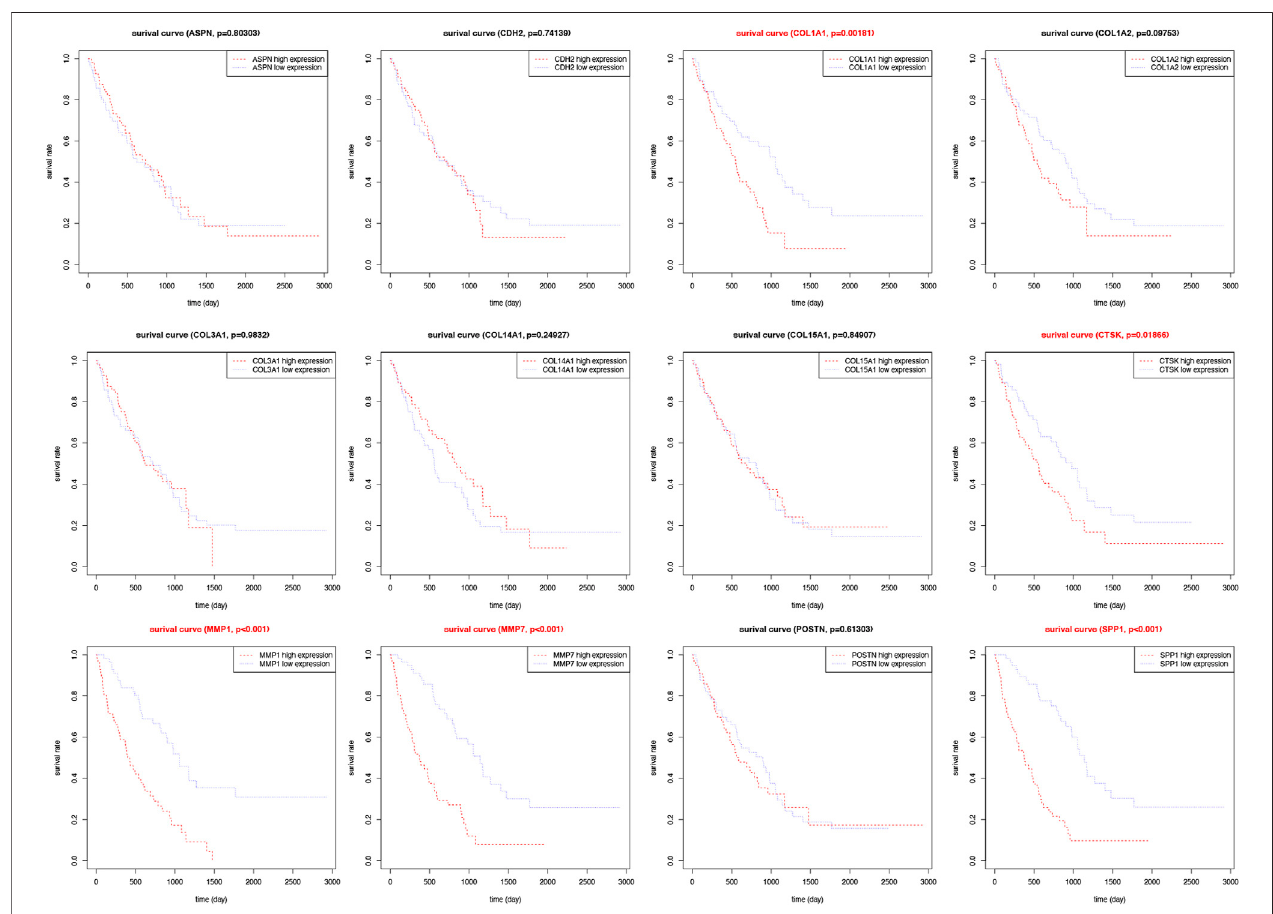
FIGURE 8 | Survival analysis for hub genes in the validation group. Kaplan-Meier plot depicting association of the expression level of twelve individual hub genes with patient survival.